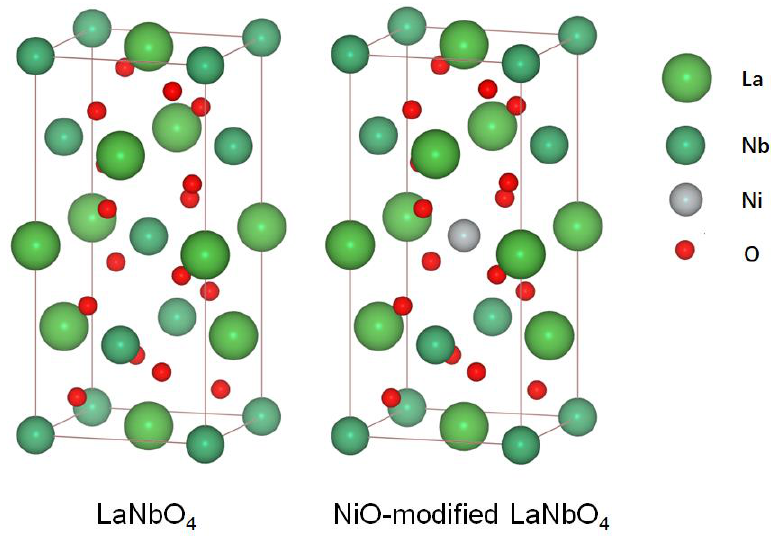
Figure 9. Configuration of LaNbO 4 - and NiO-modified LaNbO 4 optimized by the DFT method using the VASP software.